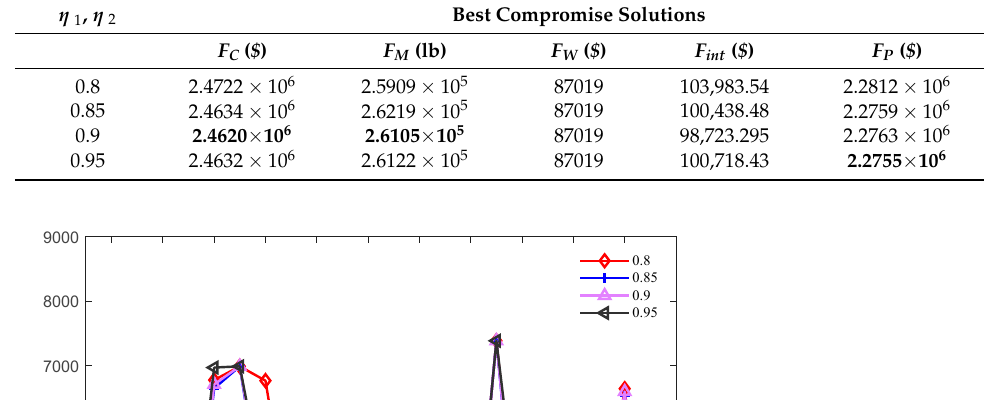
Table 11. The best compromise solutions obtained at different confidence levels.